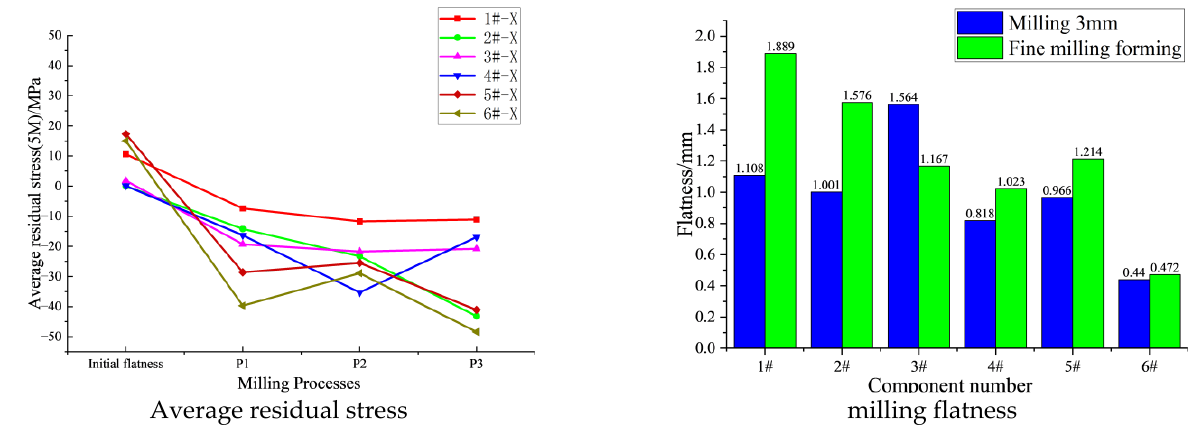
Figure 11. Average residual stress and forming flatness comparison.